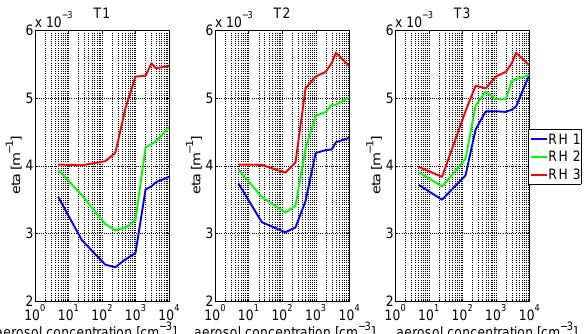
Figure 6. Minimal values of the surface area to volume ratio (eta) for each simulated cloud as a function of the aerosol concentration. T1 represents a profile with an inversion layer located at 4km, T2 at 3km, and T3 at 2km. RH1 represents a profile with 95% RH in the cloudy layer, RH2 90%, and RH3 80%. Each curve represents 10 simulations performed for an initialization profile (a total of nine